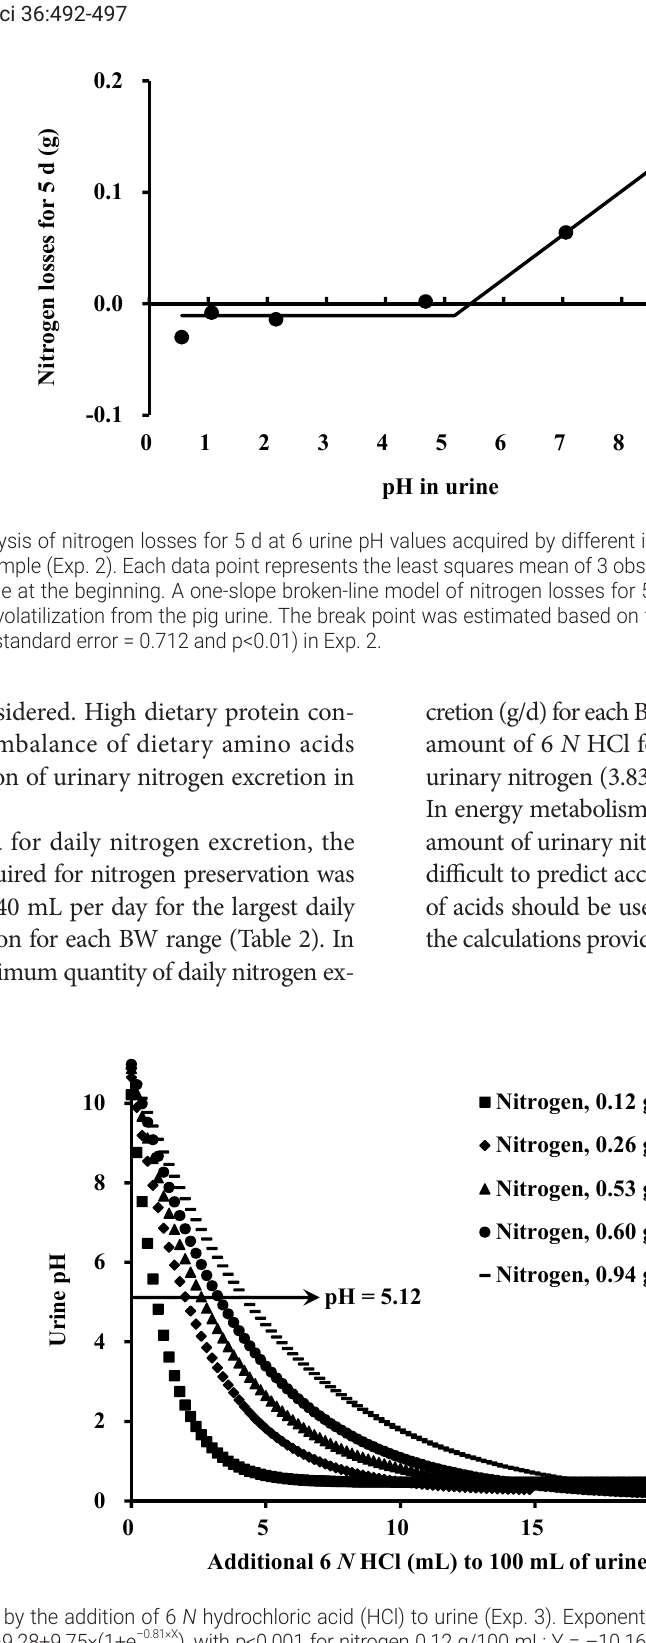
Figure 2. Urine pH changes by the addition of 6 N hydrochloric acid (HCl) to urine (Exp. 3). Exponential models were developed for each urinary nitrogen concentration: Y = –9.28+9.75×(1+e –0.81×X ), with p<0.001 for nitrogen 0.12 g/100 mL; Y = –10.16+10.41×(1+e –0.38×X ), with p<0.001 for nitrogen 0.26 g/100 mL; Y = –10.26+10.57×(1+e –0.30×X ), with p<0.001 for nitrogen 0.53 g/100 mL; Y = –10.80+10.89×(1+e –0.24×X ), with p<0.001 for nitrogen 0.60 g/100 mL; Y = –10.98+10.93×(1+e –0.18×X ), with p<0.001 for nitrogen 0.94 g/100 mL. The required concentrations of 6 N HCl to achieve a urine pH less than 5.12 were 0.92, 2.01, 2.61, 3.24, and 4.20 mL/100 mL for urinary nitrogen concentrations of 0.12, 0.26, 0.53, 0.60, and 0.94 g/100 mL, respectively.